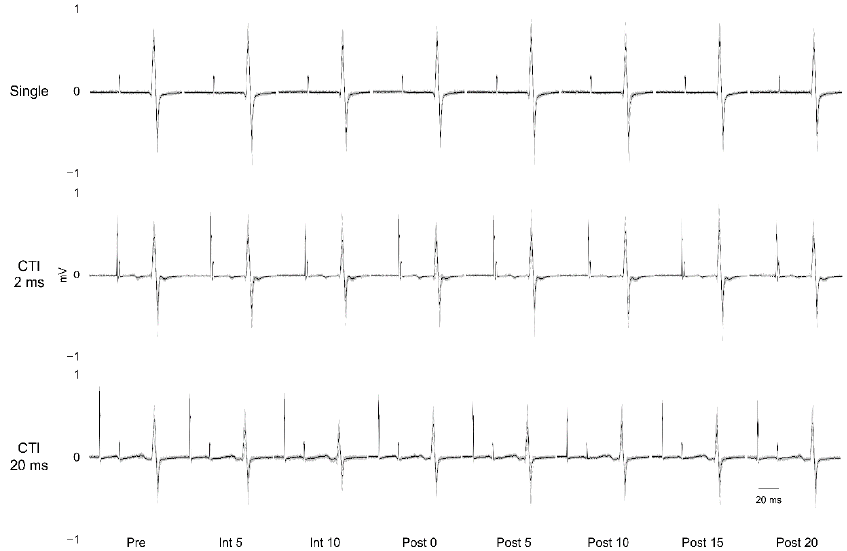
Figure 3. Tracing raw data-Sol muscle. The figure depicts a representative raw data-trace of a subject during anodal-tDCS. Stimulation conditions: single, CTI: 2 ms (DRI), and CTI: 20 ms (D1 inhibition), and waveforms of Sol H-reflex: 12. Bold black lines are averages of the 12 waveforms. The horizontal axis is the measurement time of RI. Brain Sci. 2020 , 10 , x FOR PEER REVIEW